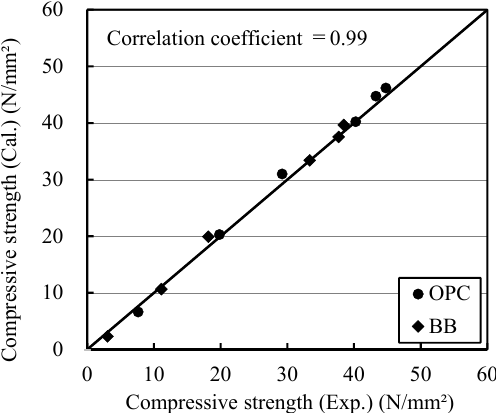
Figure7. Figure 7. Relationship between the measured compressive strength and calculated compressive strength.